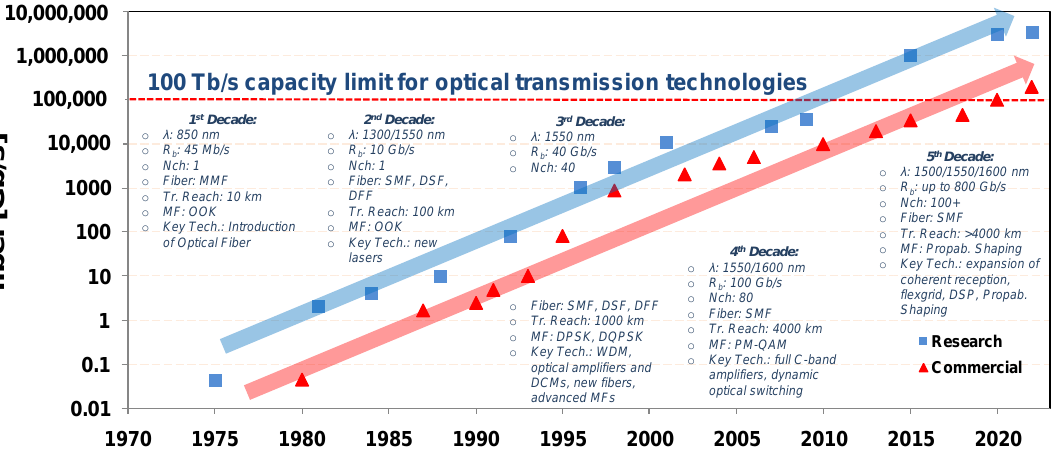
Figure 29. Evolution of transported capacity within a single mode fiber over the last 50 years (based on [82 – 84]).